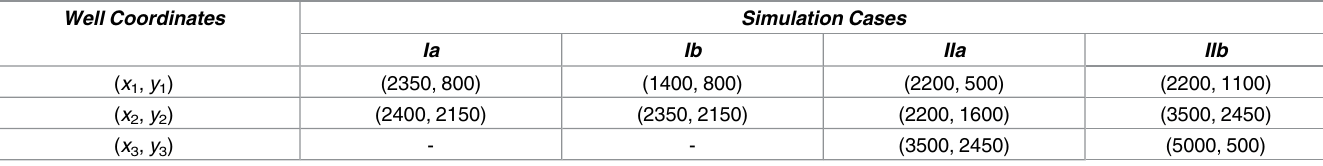
Table 3. Well Coordinates for the first group of simulation